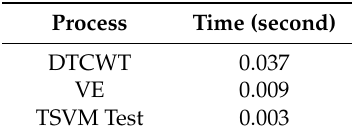
Table 7. Online-Prediction Computation